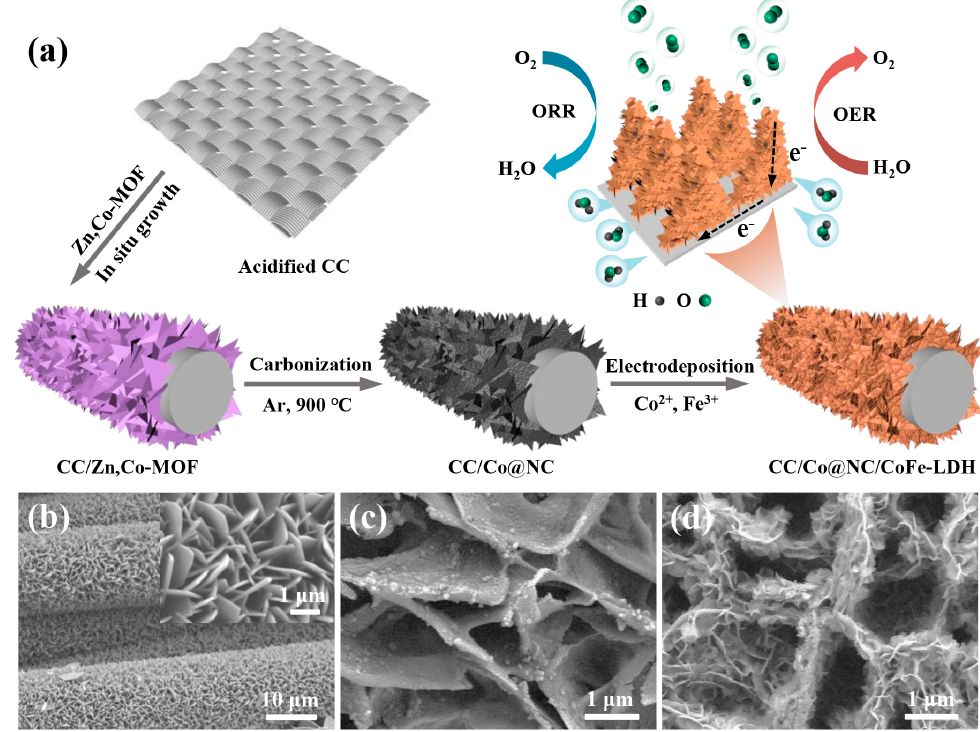
Figure 1. ( a ) Schematic diagram depicting the synthesis process of CC/Co@NC/CoFe-LDH. SEM images of ( b ) CC/Zn, Co-MOF, ( c ) CC/Co@NC, and ( d ) CC/Co@NC/CoFe-LDH-700. images of ( b ) CC/Zn, Co-MOF, ( c ) CC/Co@NC, and ( d )